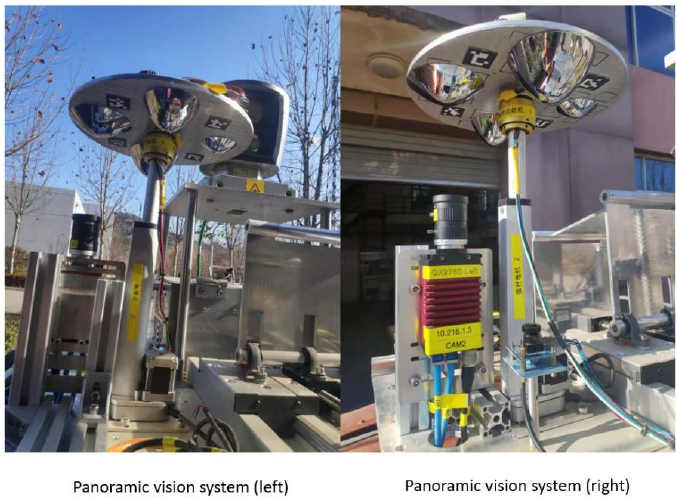
Figure 22. Binocular stereo panoramic systems to be calibrated.